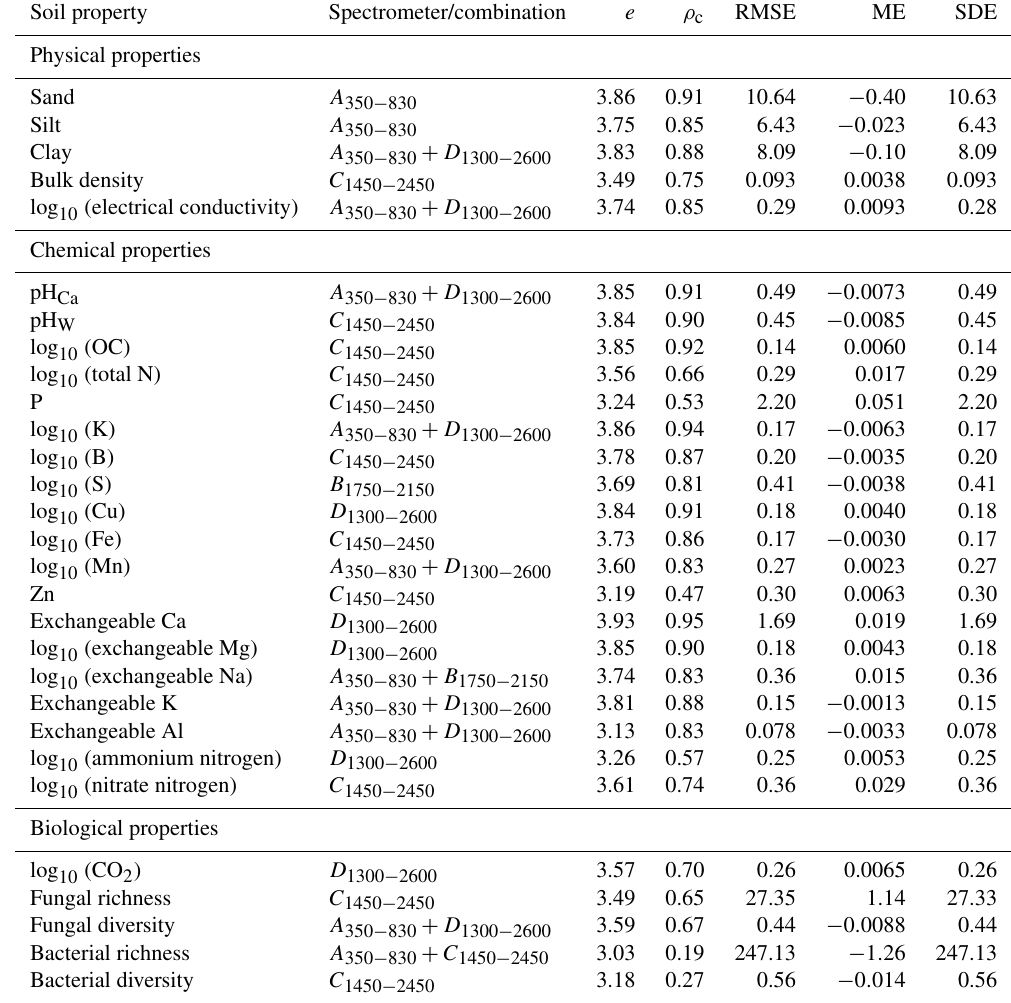
Table 5. Evaluation statistics for the miniaturised spectrometers and combinations showing the highest e score for individual soil properties. Soil